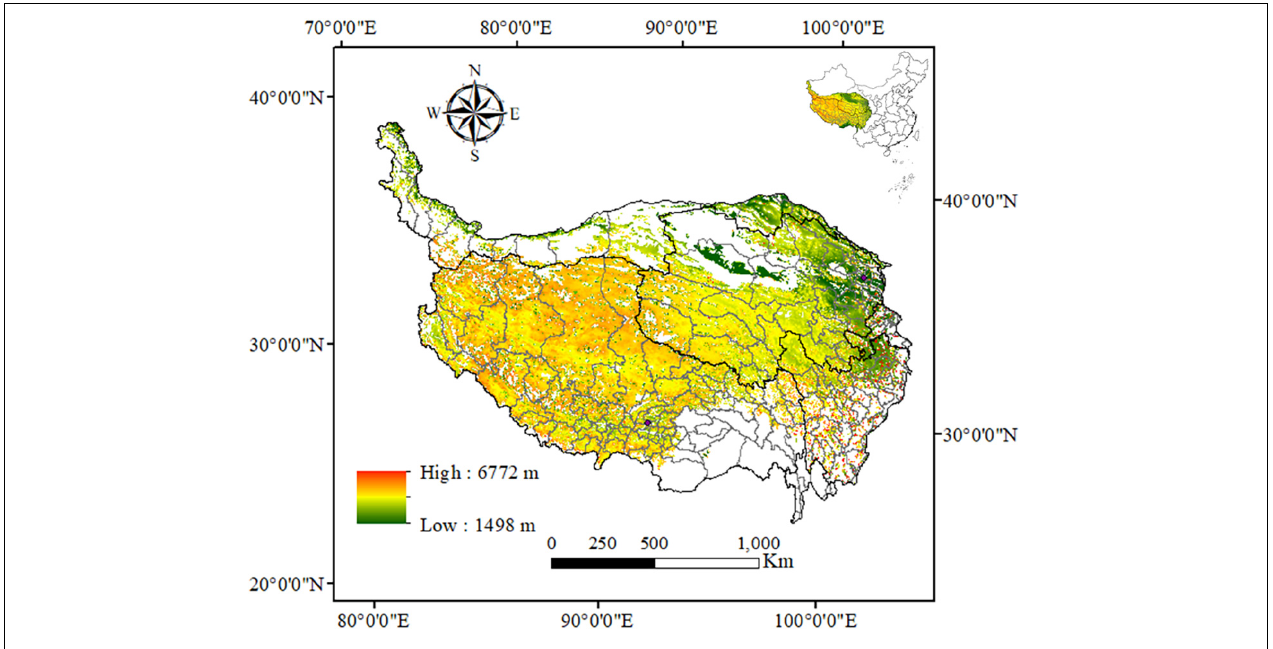
FIGURE 1 | Location and elevation of the study